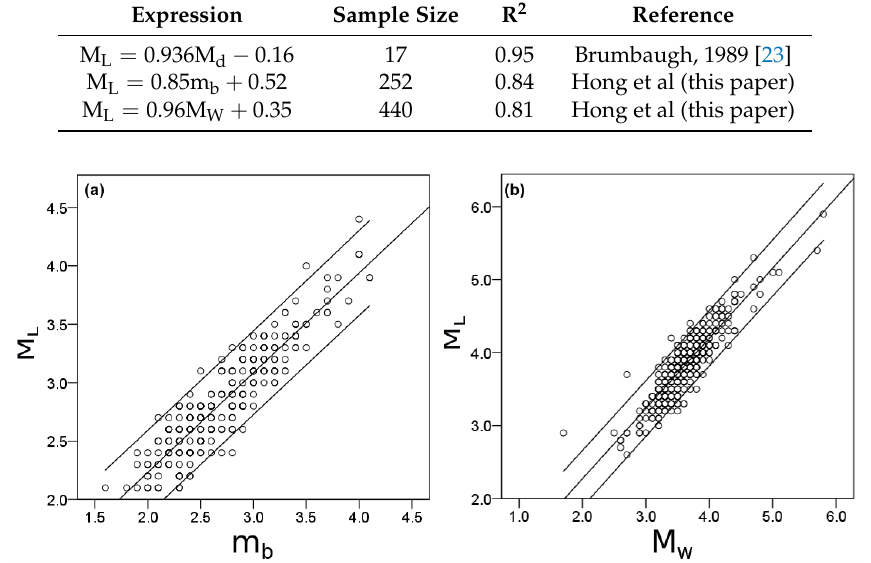
Figure 1. Linear regression plots for ( a ) M L vs. m b and ( b ) M L vs. M W for all seismic events occurred